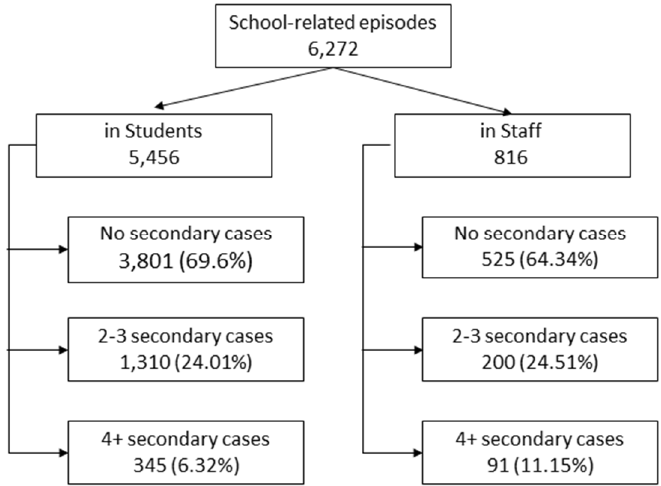
Figure 3. Cases of COVID-19 infection occurring at school.